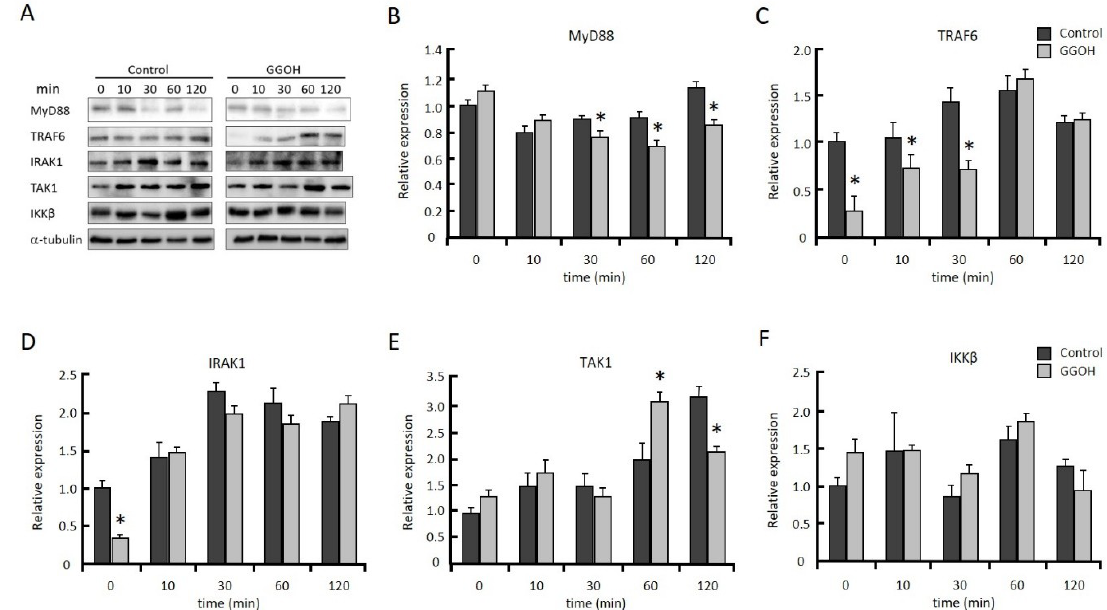
Figure 3. GGOH modulates NFκB signaling molecules. Differentiated THP-1 cells were incubated with or without 10 µM GGOH for 24 h, then stimulated with LPS. The cells were harvested after the indicated time of LPS treatment, and protein levels were measured by western blot, as described in the experimental procedures ( A ). Relative protein levels of MyD88 ( B ), tumor necrosis factor receptor-associated factor 6 (TRAF6) ( C ), interleukin-1 receptor-associated kinase 1 (IRAK1) ( D ), TAK1 (E ), and IKKβ ( F ). All values represent the mean ± SEM; n = 3. * The values are significantly different